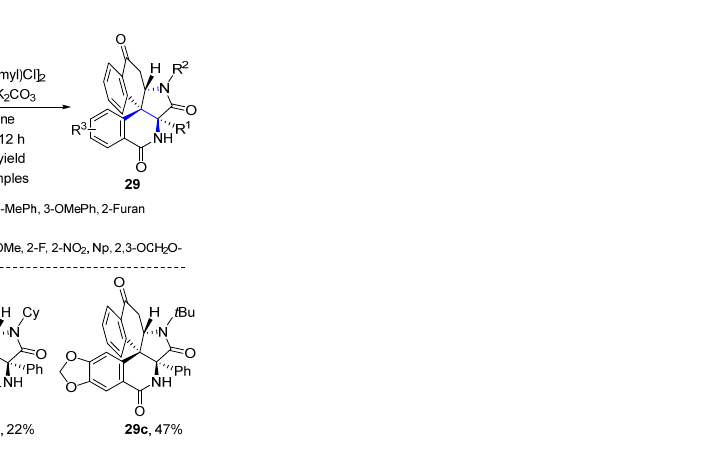
Scheme 15. Palladium ‐ catalyzed post ‐ Ugi reactions for the synthesis of Zephycarinatine and Zeph ‐ ygranditine scaffolds.